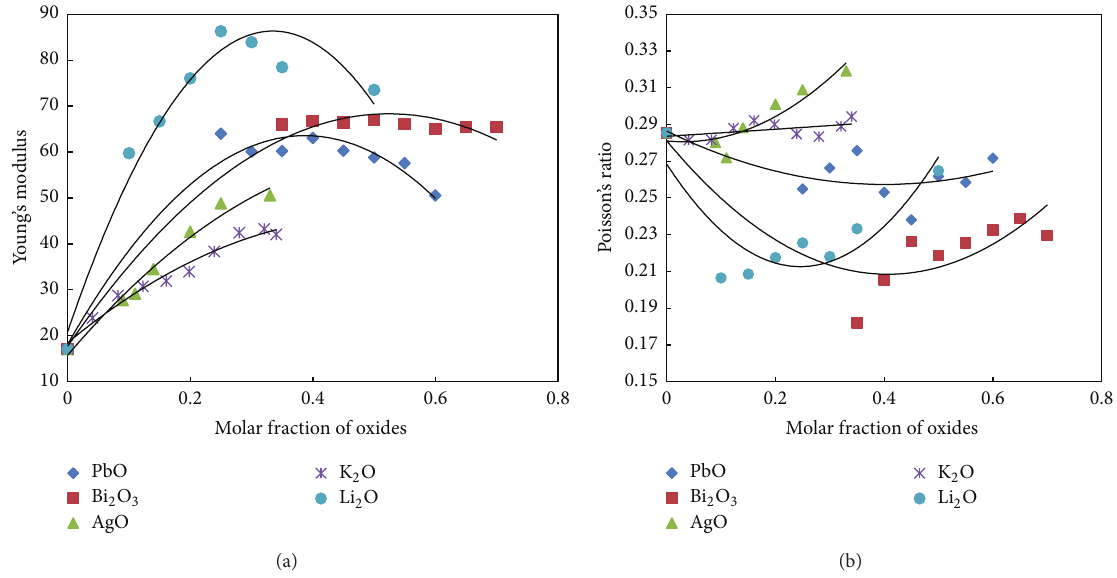
Figure 4: (a) Young’s modulus and (b) Poisson’s ratio of binary borate glasses as a function of modifier oxides concentration of Pb and Bi oxides with those of Ag, K, and Li [22,